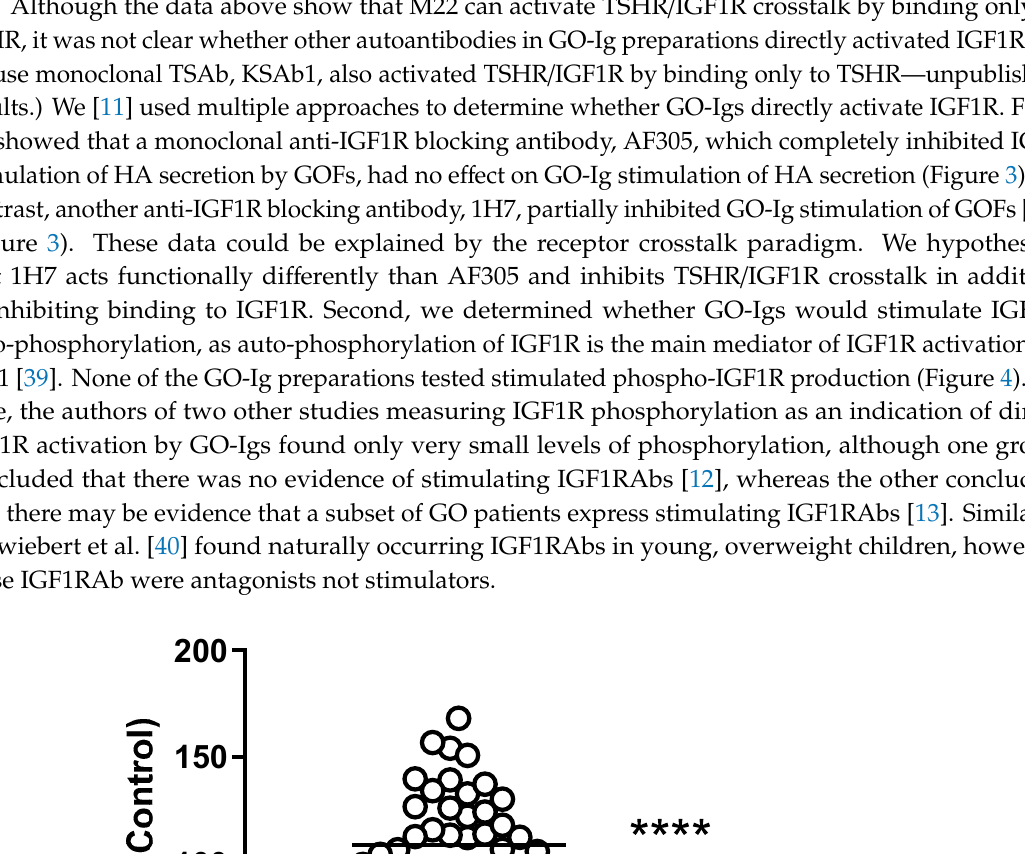
Reprinted from [8] .